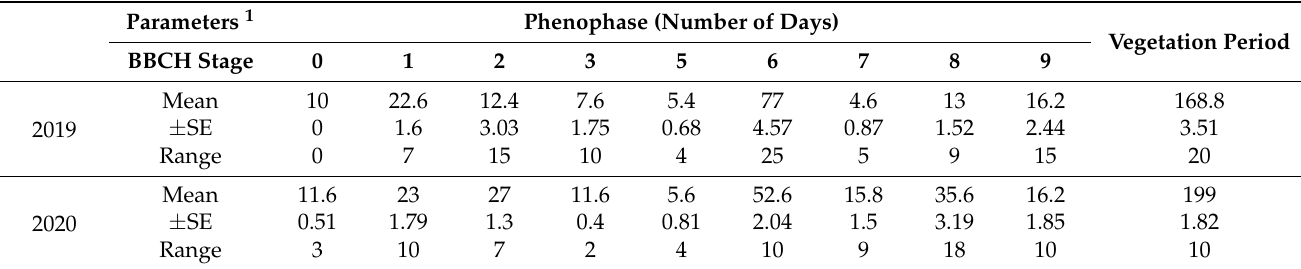
Table 4. Descriptive statistics of Agastache sp. phenophases in Cluj-Napoca.